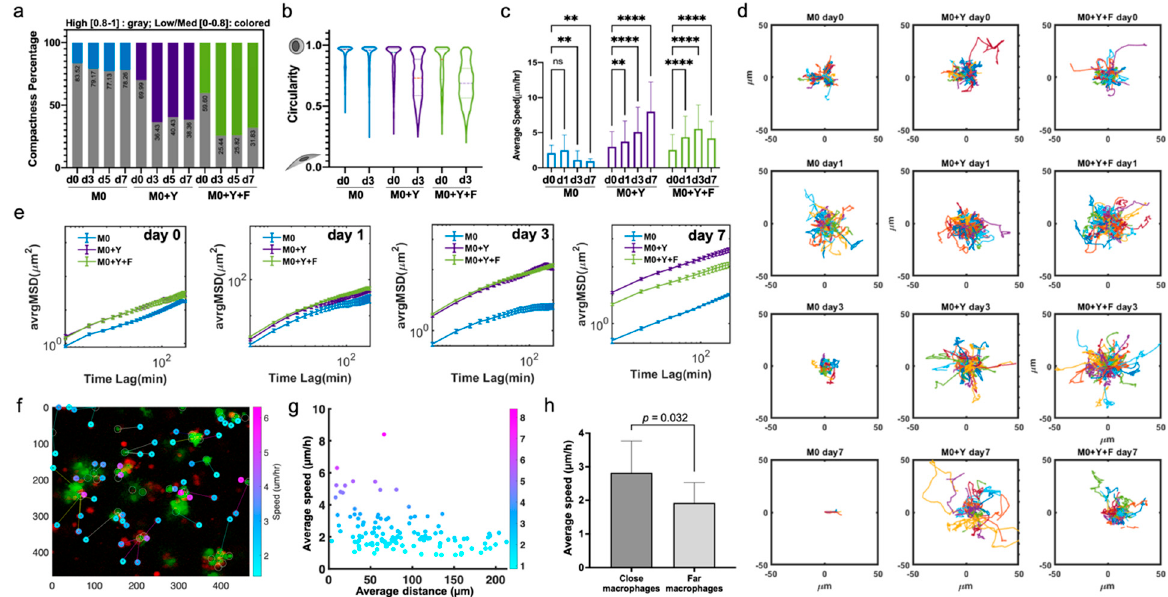
Figure 4. Significant morphology and motility changes in BMDM activation in 3D co-cultures over time. ( a ) Generation of cell protrusions in M0 BMDMs across multiple days exposed to different 3D environments. Compactness was calculated as described in the methods. Cells were first classified into two categories, low/medium compactness [0–0.8] and high compactness [0.8–1]. For each condition and time, proportion of cells in each category were calculated and plotted as percentages of total. Gray bar, high compactness [0.8–1], colored bar, low/med compactness [0–0.8]. ( b ) Violin plots showing the early changes in BMDM morphology in different 3D environments. Circularity index was calculated as described in MM. ( c ) Average migration speed of macrophage, data shown as Mean +/ − SD. ( d ) Overlaid individual migration trajectories of M0 BMDMs in different 3D environments, at different timepoints. ( e ) Average mean square displacement (avrgMSD) of M0 BMDMs across multiple days exposed to different 3D environments. data shown as Mean +/ − SEM. ( f ) Representative image of calculation of distance between macrophages and the closest tumor cell at early timepoint (day 1). Overlaid data on individual average speed of the BMDM. ( g ) Scatter plot of M0 BMDMs average speed vs. distance to the closest YUMM cell after 24 h of 3D co-culture. ( h ) The bar plots compare the average speed of the top 15 closest and top 15 farthest macrophages from the nearest YUMM cell at day 0. ns: Not significant, ** p < 0.01, **** p < 0.0001.